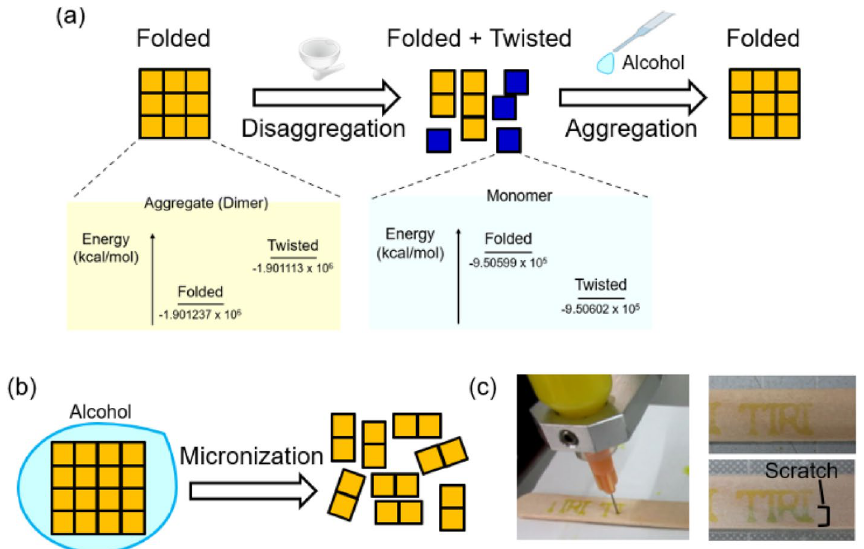
Figure 2. ( a ) Illustration of the relationship among conformation, color change, and aggregation/ disaggregation of FA, and calculated energy levels of the conformers (the aggregates were simplified to dimers to reduce the computational cost). ( b ) Micronization while using alcohol to suppress mechanochromism. ( c ) Preliminary demonstration using a dispenser to deposit ground particles of